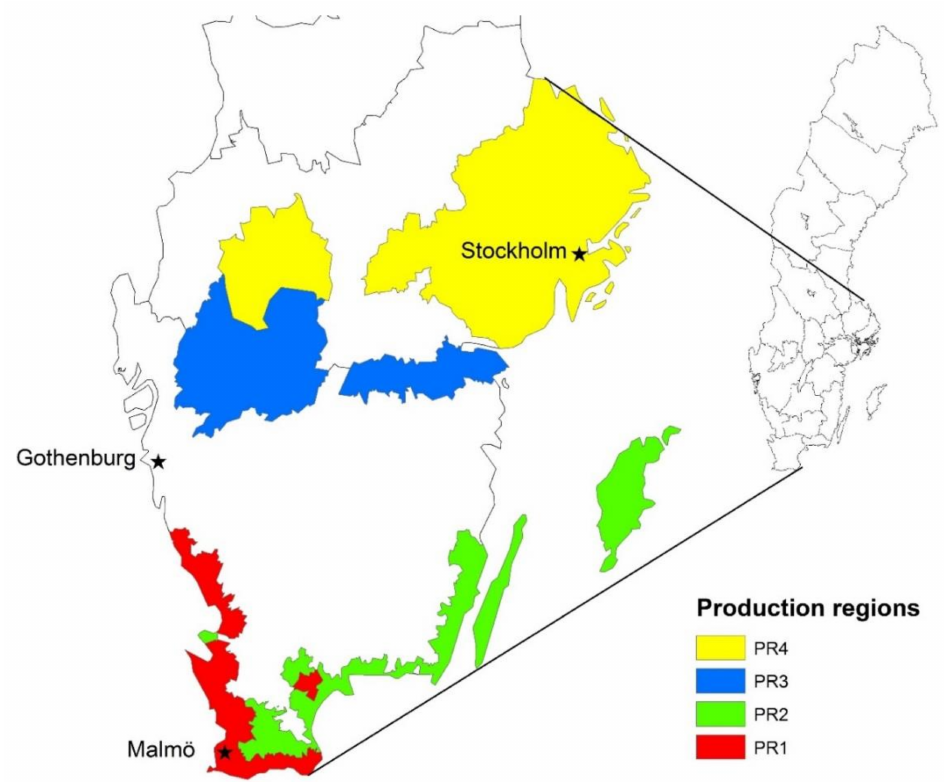
Figure 1. Map showing the four most productive agricultural regions in Sweden.